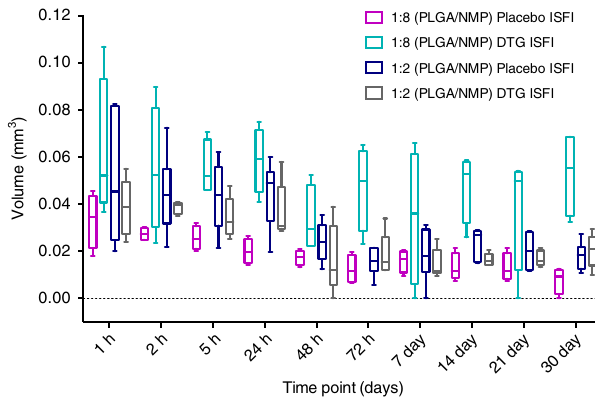
Fig. 6 Analysis of the change in implant volume over time. Measurement of the implant volume decrease that occurs over 30 days calculated from 2D in vivo ultrasound images for four different ISFI formulations ( n = 7 mice per group, see also Supplementary Figs. 4 and 5). Boxes represent 25th to 75th percentiles, and whiskers the range from the minimum to maximum values. Source data are provided as a Source Data fi of solvent diffused out leaving behind a smaller implant of PLGA (placebo) or PLGA/drug (DTG-ISFI). In addition, when more solvent diffused out, a larger volume of water diffused into the polymer implant, which in turn accelerated the ester hydrolysis of the PLGA implant. The ability to control the rate of implant erosion by changing the ratio of PLGA/NMP demonstrates the fl exibility to fi ne-tune the formulation. In vivo pharmacokinetic studies . To assess drug release kinetics in vivo using the ISFI formulations, initial pharmacokinetic stu- dies were carried out using single-drug ISFIs (Figs. 7a and 8). drugs in 1:2 w/w PLGA/NMP (PLGA 27 kDa). For each for- mulation, the indicated dose of the individual drug was injected subcutaneously into NOD scid gamma chain knockout mice (NSG) mice ( n = 4) based on their body weight, and plasma samples were collected on day 1, 3, 7, 14, 21, and 30 and analyzed for drug concentration (Figs. 7a and 8). Dolutegravir and dar- unavir, together with ritonavir were administered at two different doses each to assess the effect of administered dose on drug release kinetics (Fig. 7b). Initial estimates for PK parameters were obtained through non-compartmental analysis (NCA) using WinNonlin Phoenix 6.1 (Pharsight, Mountain View, CA) on the composite median PK pro fi le. Plasma concentrations